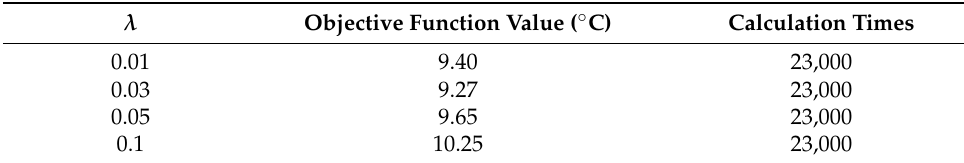
Table 3. Optimization results under different λ .